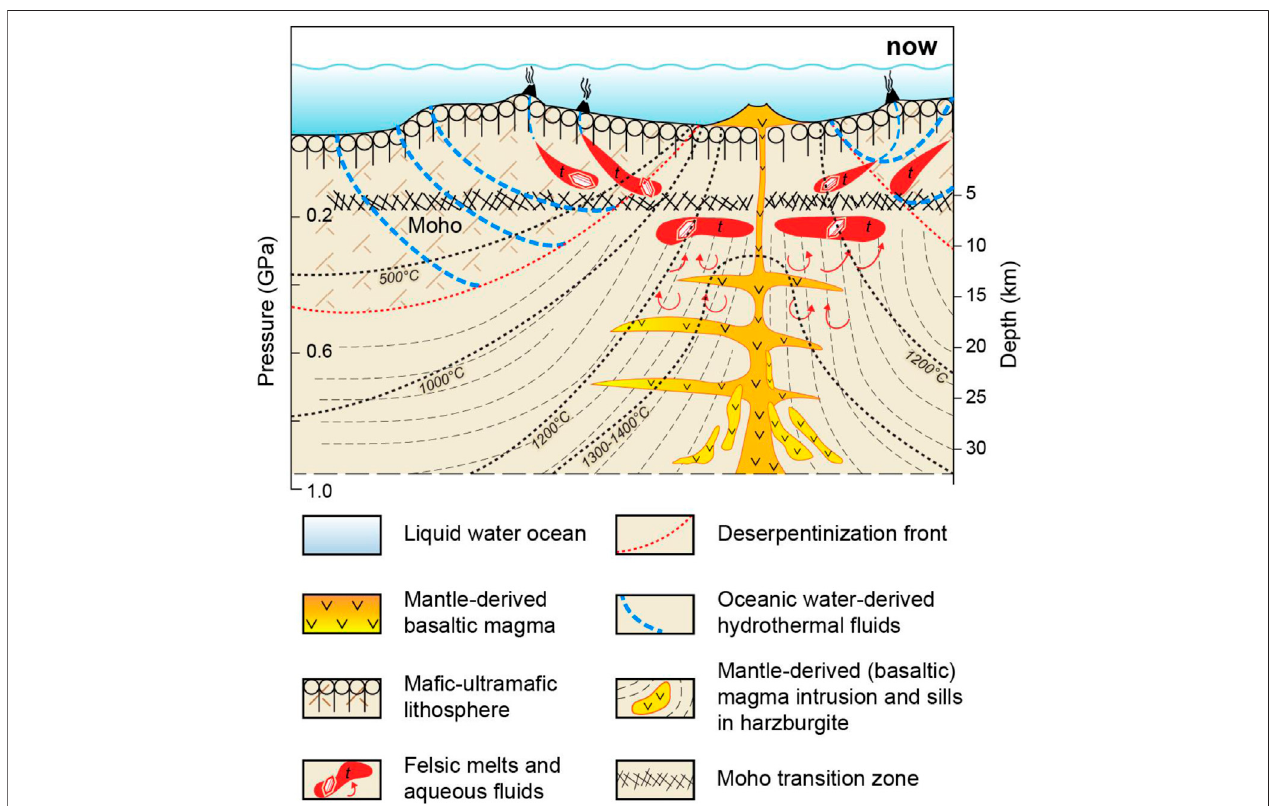
FIGURE 1 | Model of formation of the modern chromitite-dunite zone in the oceanic lithosphere after Borisova et al. Intrusion of mantle-derived magmas into hydrated (serpentinized) mantle initiated the dehydration process and prograde metamorphism. The dehydrated peridotite-basaltic melt interaction produces dunite- chromitite rock sequence associated to the felsic melts and aqueous fl uids in the mantle and the mantle-crust transition zone. Borisova et al. demonstrate that similar mechanismofthehydratedperidotite-basalticmeltinteractionandpartialmeltingoftheperidotitemighthappenandresultinfelsiccrustformationonearlystepsof the protocrust evolution during Hadean and Noachian eons on Earth and Mars,